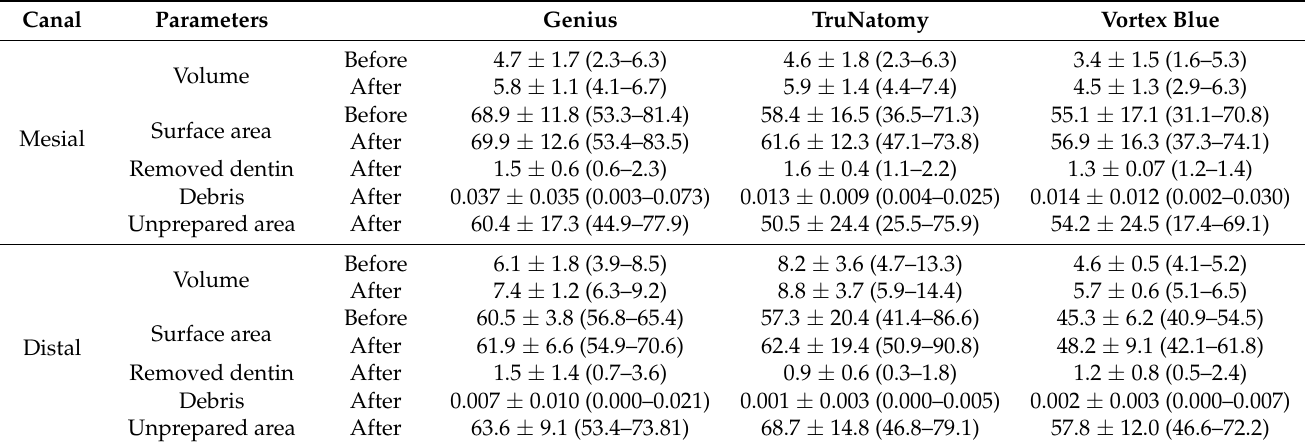
Table 2. Pre- and post-operative parameters (mean, standard deviation, and range interval) evaluated in mesial (n = 24) and distal (n = 12) root canals of mandibular molars after preparation protocols using 3 rotary